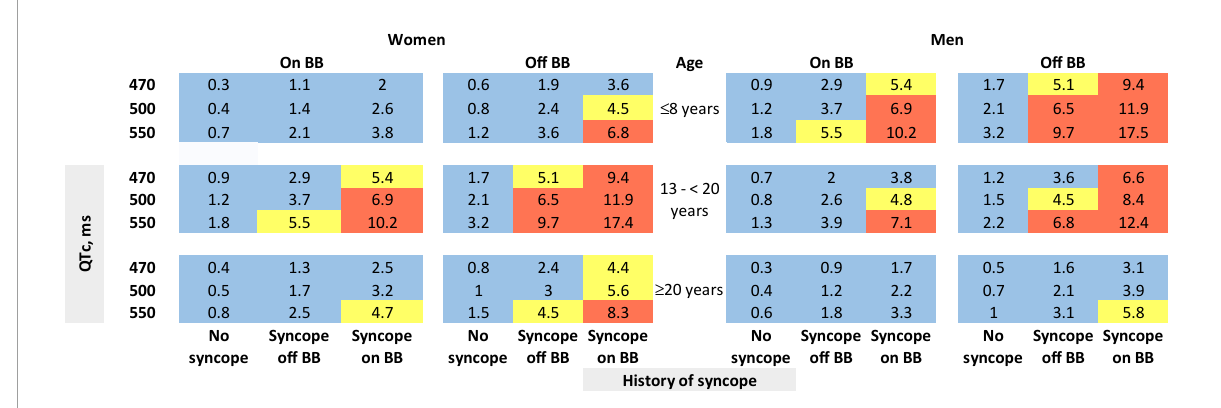
FIGURE1 Predicted 5-year risk of life-threatening arrhythmic events (aborted cardiac arrest, sudden cardiac death, or appropriate ICD shocks) for some example risk factor combinations for patients with a QTc ≥ 470 ms. Blue color indicates a predicted 5-year risk of < 4%, yellow color indicates a predicted 5-year risk of 4– < 6%, and red color indicates a predicted 5-year risk of ≥ 6%. Numbers in this figure are percentage. BB: beta-blockers. We chose three QTc values (470, 500, and 550 ms) and three age groups at baseline ( ≤ 8 years, 13– < 20 years, and ≥ 20 years) as examples. We did not show the age group of 8–13 years. Given that the 5-year risk prediction interval includes age 13 for patients aged 8–13 years at baseline, in this age group each unique age has a unique predicted risk. Thus, graphical presentation can be cumbersome. The